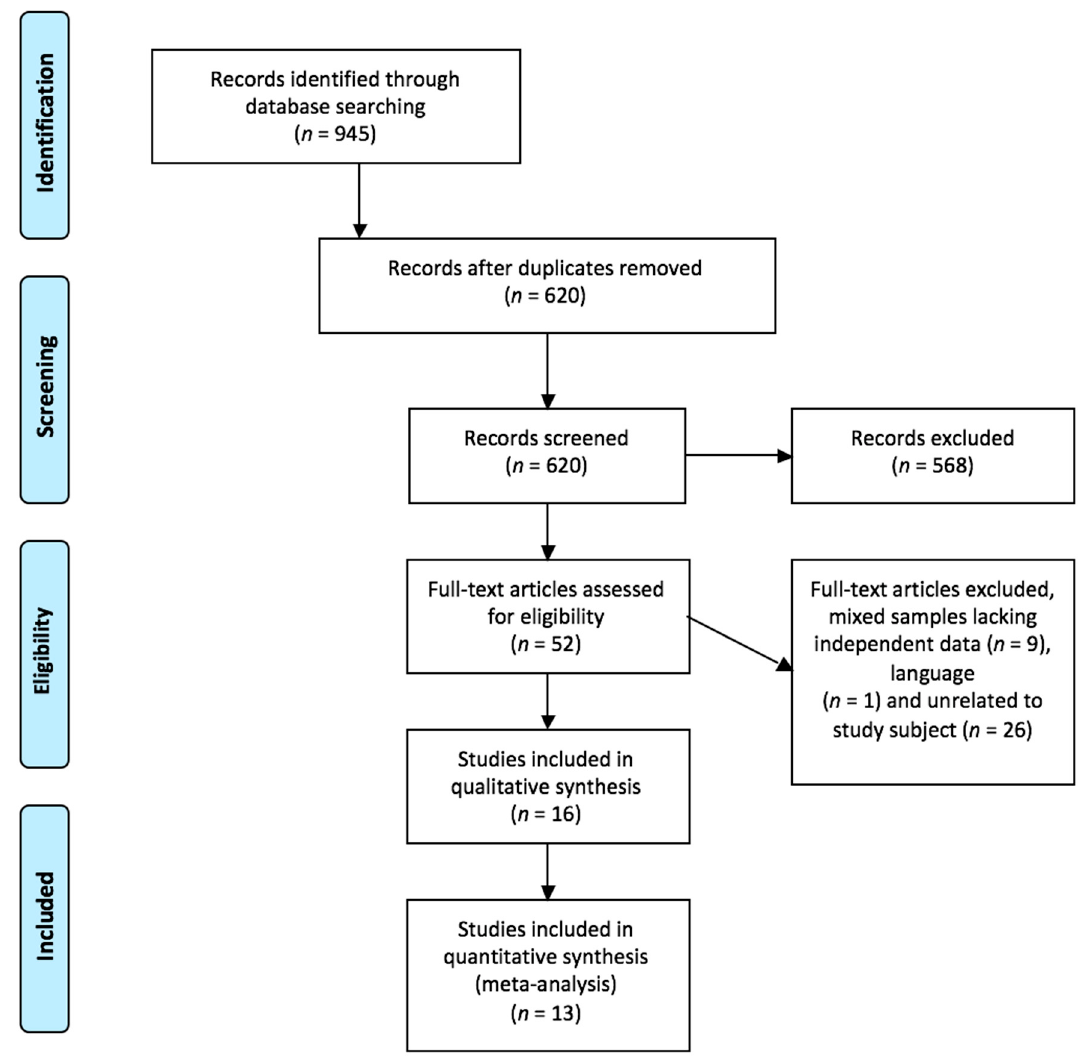
Figure 1. Flow search diagram. Study selection process for the meta-analysis.